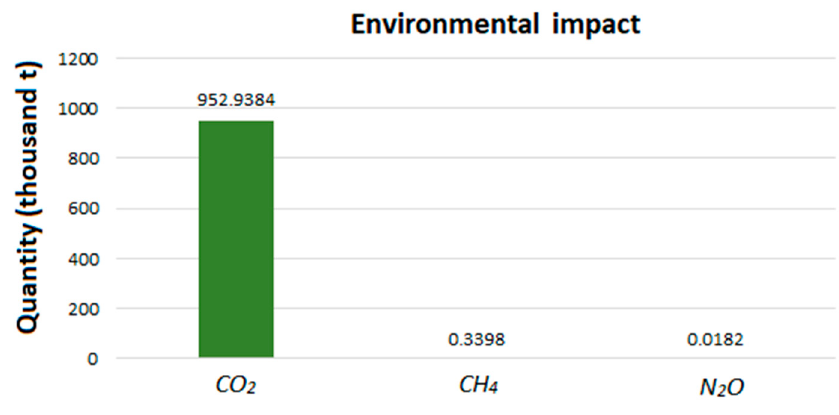
Figure 7. Environmental assessment of symbiotic environment in Sodankylä.